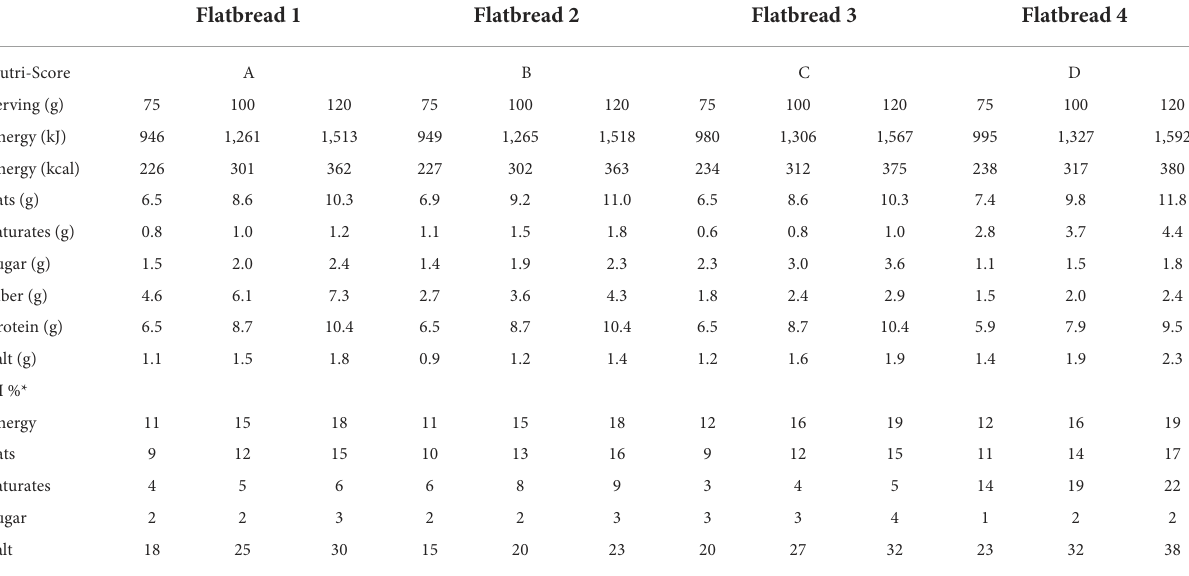
TABLE 5 Energy and nutrient content per serving (75, 100, and 120g), in different flatbread items with different Nutri-Score sold on the Italian market, reported as absolute values and as percentage of the Reference Intakes, as in NutrInform Battery (Legend: svg, serving). Flatbread 1 Flatbread 2 Flatbread 3 Flatbread